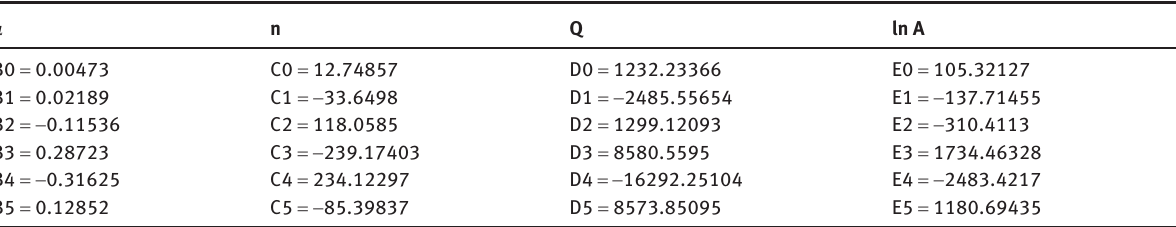
Table 4: Coefficients of the polynomial fit for α , b , n, Q and A of FV520B steel